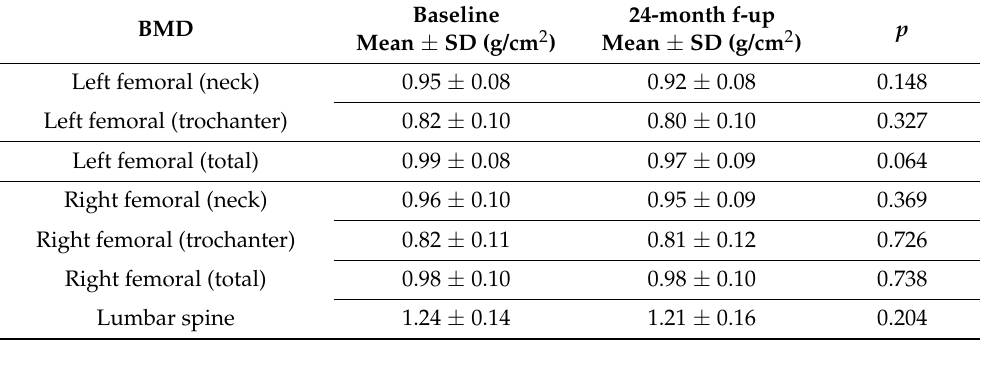
Table 2. BMD values at baseline and after the 24-month follow-up.